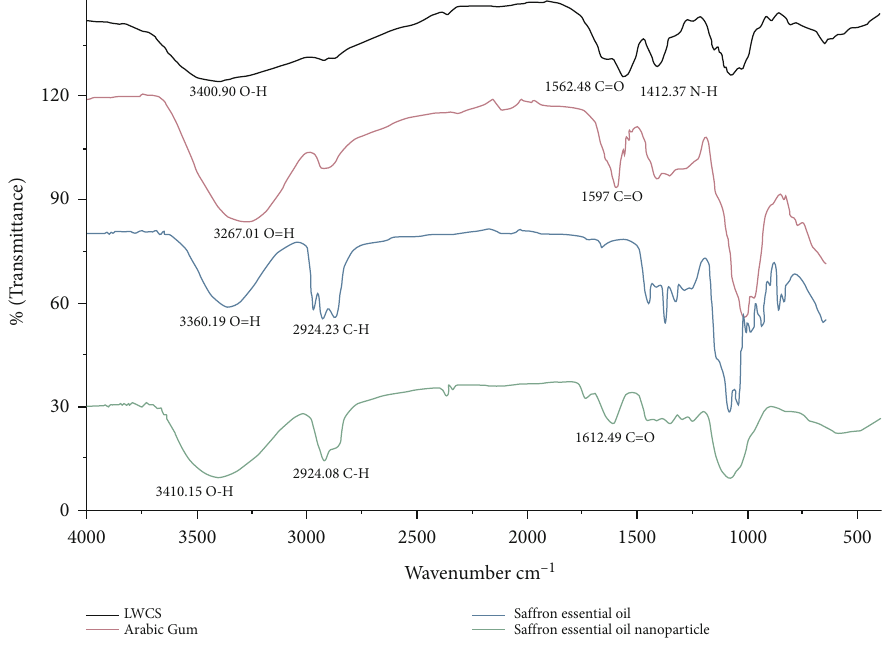
Figure 6: FTIR of sa ff ron essential oil